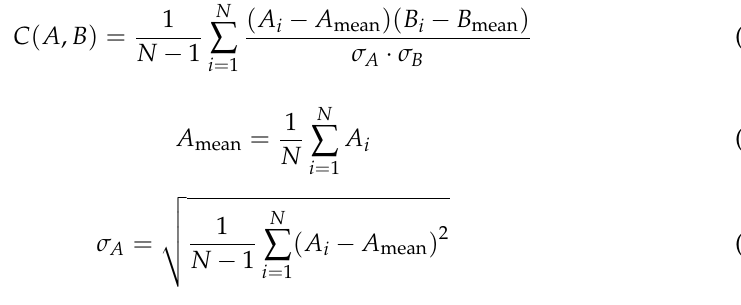
Table 2. Correlation coefficients of outage duration and parameters of the fitted CLPU model. Correlation with Outage Duration Parameter